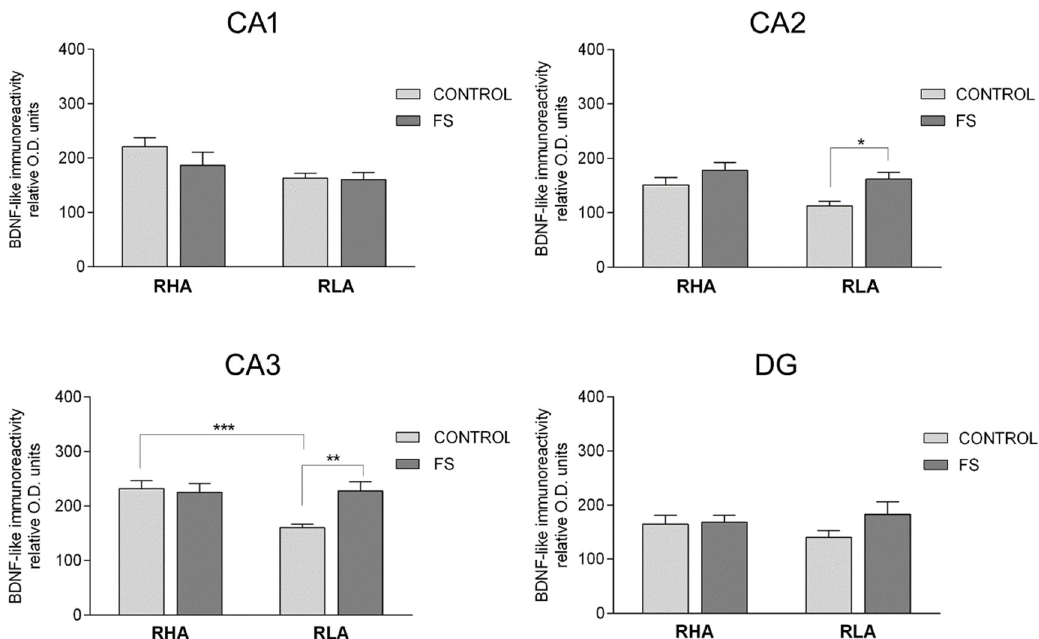
Figure 4. Densitometric analysis of the BDNF-like immunoreactivity in the CA1–CA3 sectors of the Ammon’s horn, and in the dentate gyrus (DG) of the dorsal hippocampus in the baseline conditions (CONTROL) and after forced swimming (FS). Columns and bars denote the mean ± S.E.M. of six rats, in each experimental group. Two different sections were analyzed for each rat. *: p < 0.05; **: p < 0.01;